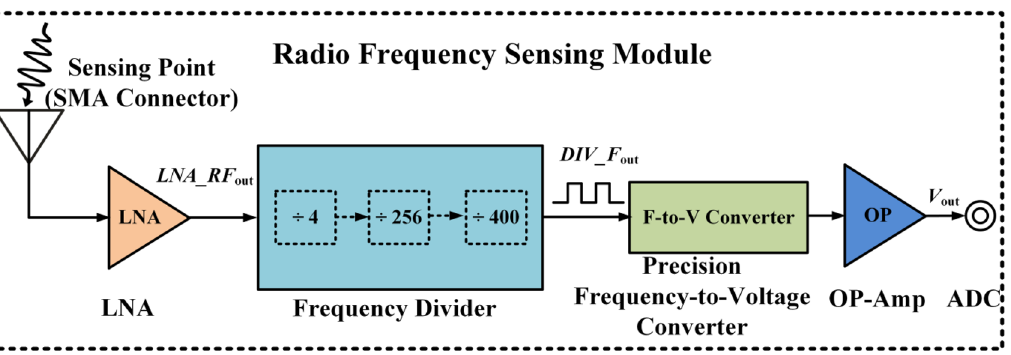
Figure 4: Block diagram of the radio frequency sensing module. It is mainly composed of a LNA, three frequency dividers, a precision frequency-to-voltage converter and an ADC.